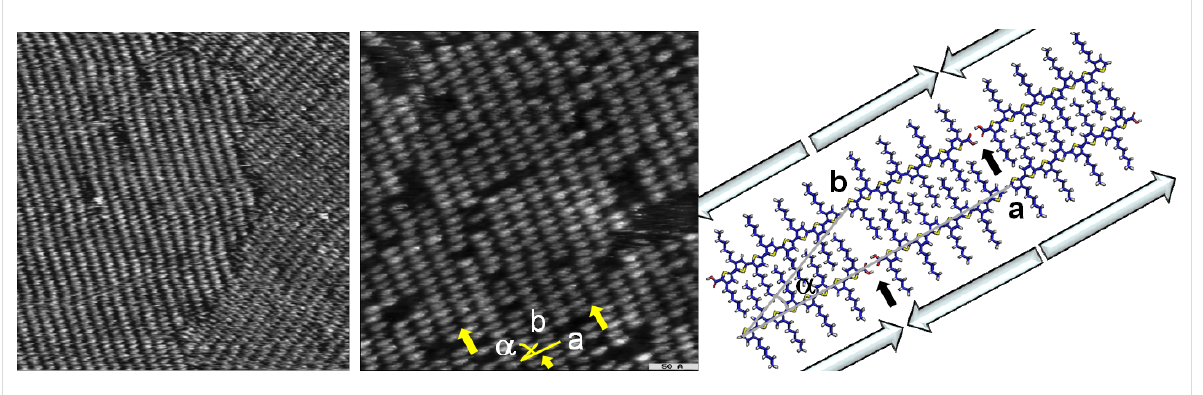
Figure 4: STM images of H8TCOOH . Left: 60 × 60 nm 2 , U = − 640 mV, I = 44 pA. Center: 30 × 30 nm 2 , U = − 725 mV, I = 35 pA. Right: Theoretical model. The small black arrows indicate the H-bonds. The big arrows show the orientation of the molecular dipole moments.